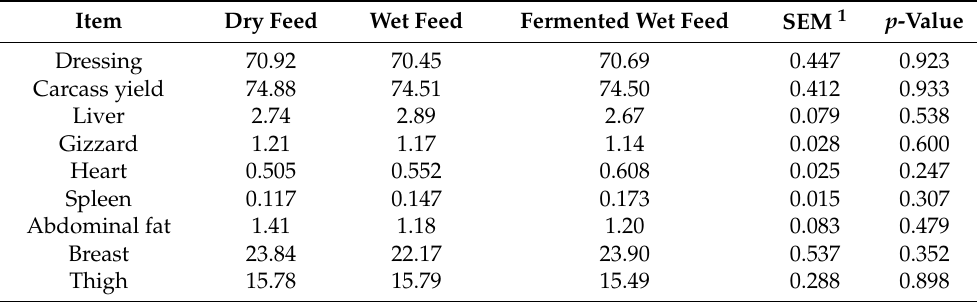
Table 4. Effect of dry, wet and fermented wet feeds on carcass traits (%) of broiler chickens at 35 days of age.